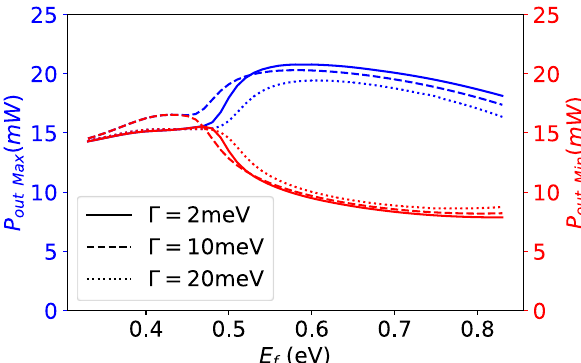
Figure 6: The maxima and minima of the output power after the transient effects have subsided. Before the bifurcation, the system has a stable fixed point so the maximum and minimum output power is identical. After the bifurcation self-pulsation begins so the maximum and minimum separate and the amplitudes grow. The relaxation rate of graphene has a small effect on the exact position of the bifurcation.